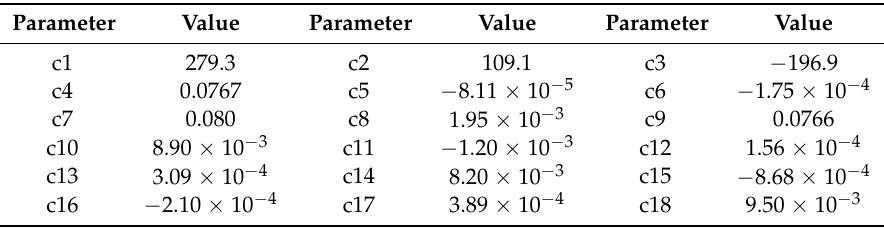
Table 2. Compensation parameters of OPM-II.